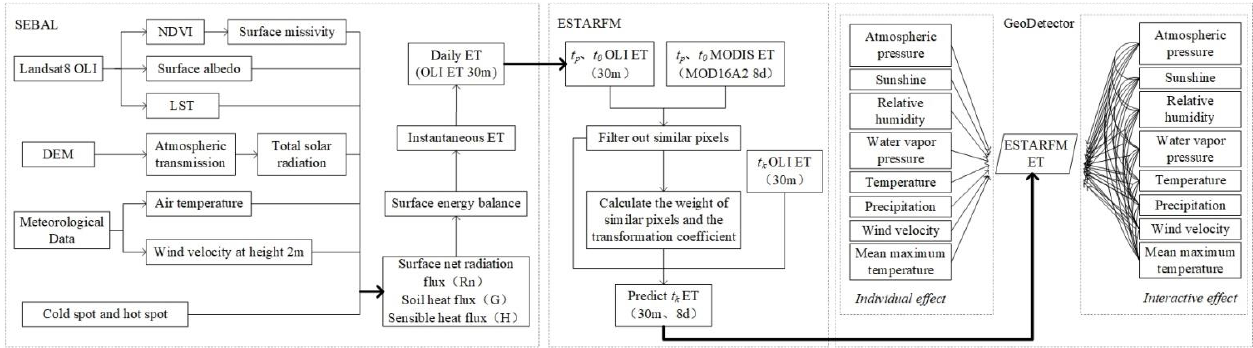
Figure 2. Technical flow